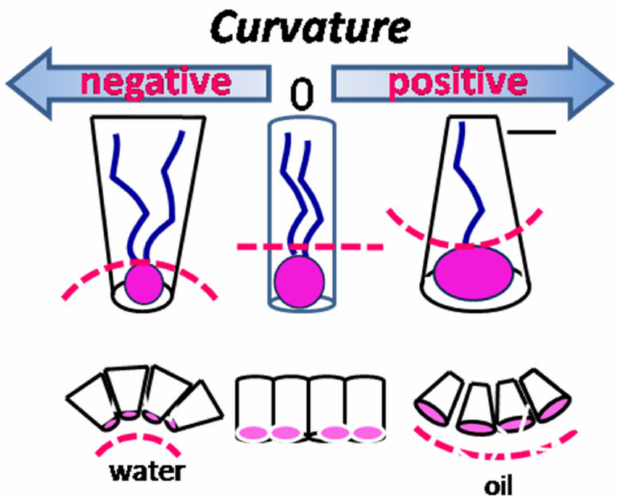
Figure 2. Correlation between the type of curvature and surfactant